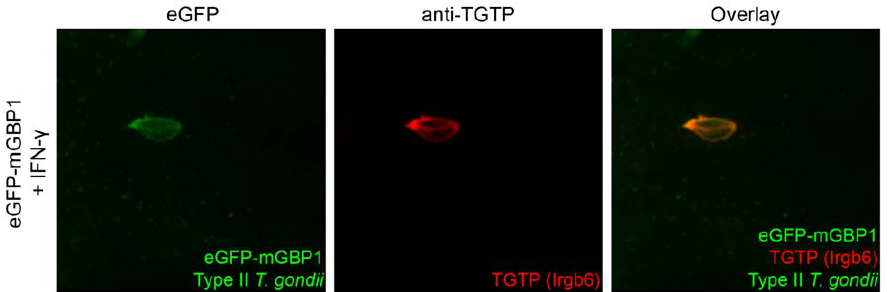
Figure 5. mGBP1 co-localizes with TGTP after infection with T.gondii . Confocal pictures show that mGBP1 co-localizes with TGTP after infection with T. gondii in vitro (B). MEFs that overexpress eGFP-mGBP1 were stimulated with 200 U/ml IFN- c overnight and infected with GFP- expressing Type II T. gondii at a MOI between 5 and 10 for 1 h. A goat polyclonal anti-TGTP antibody was used for staining.